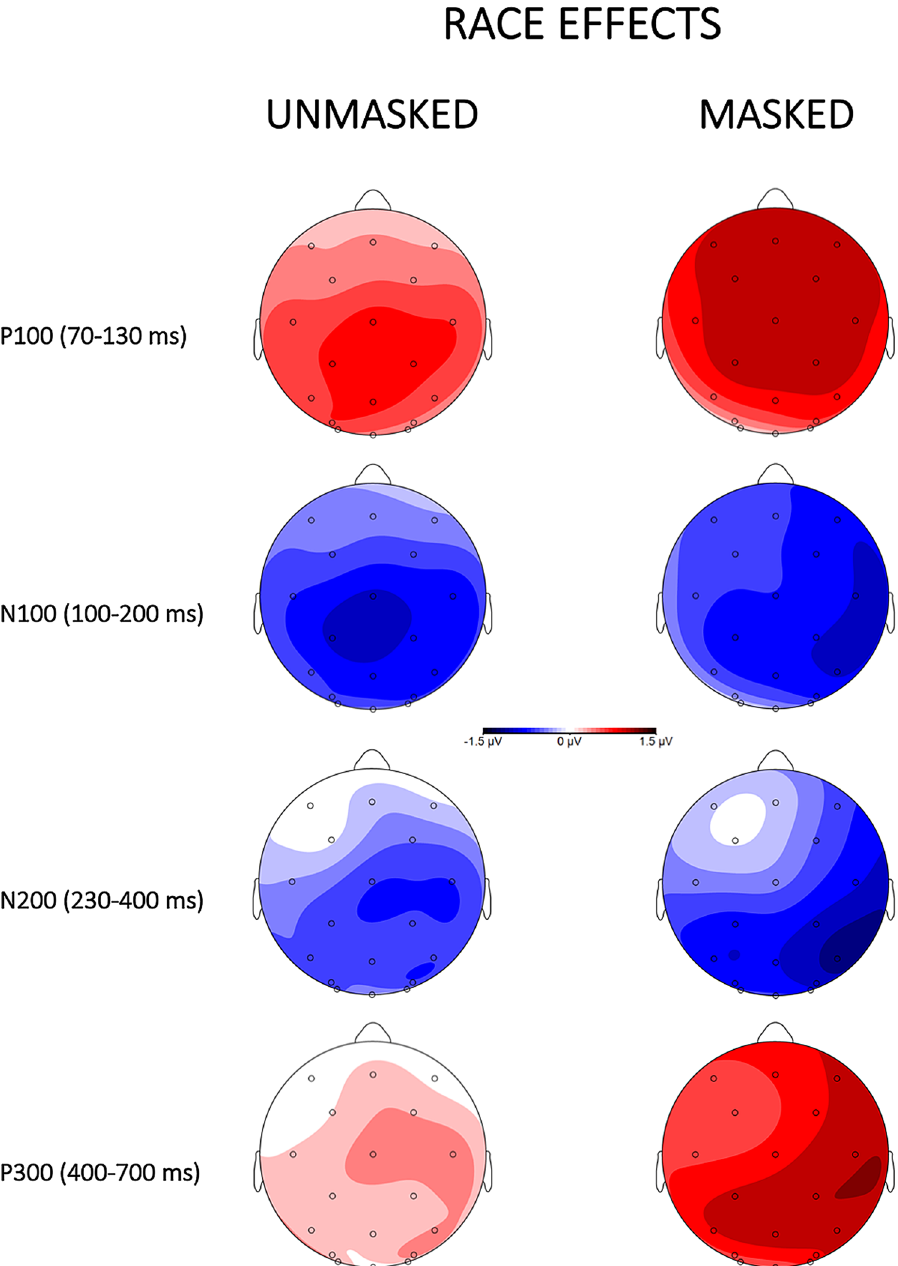
Figure 4. Topographical scalp distributions for target faces separately for the unmasked (left panel) and masked (right panel) procedures as a function of race (other-race vs own-race) in the four critical time windows, created by subtracting other from own-race